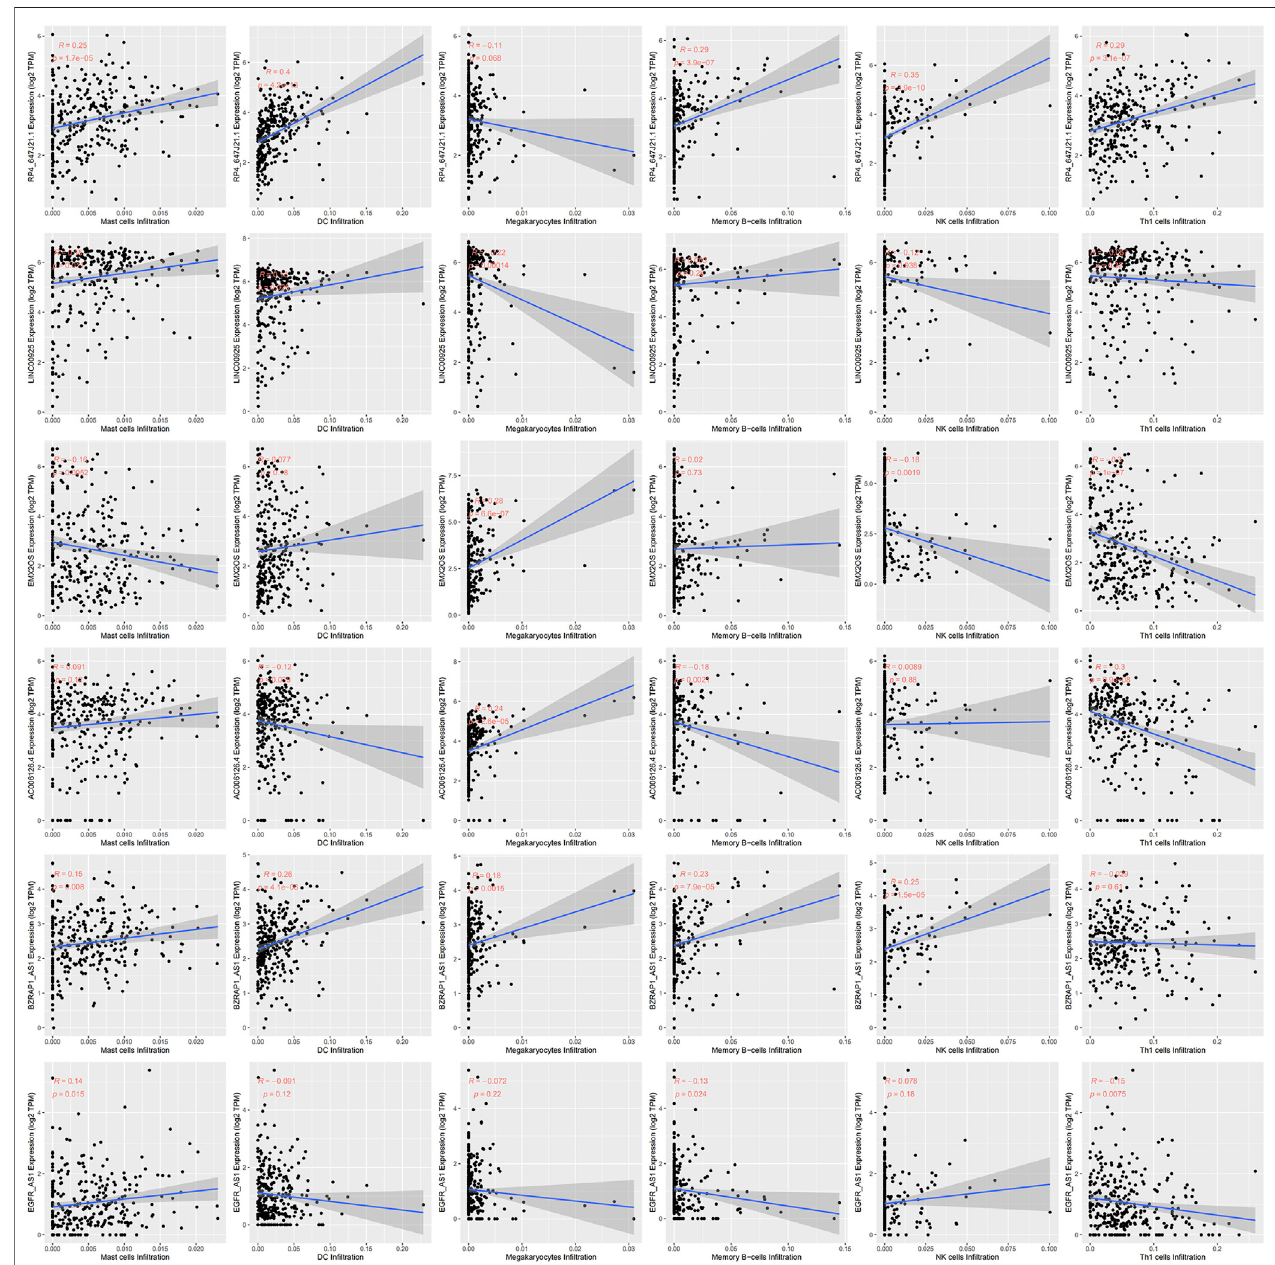
FIGURE 5 | Correlations between hub signatures and tumor-in fi ltrating immune